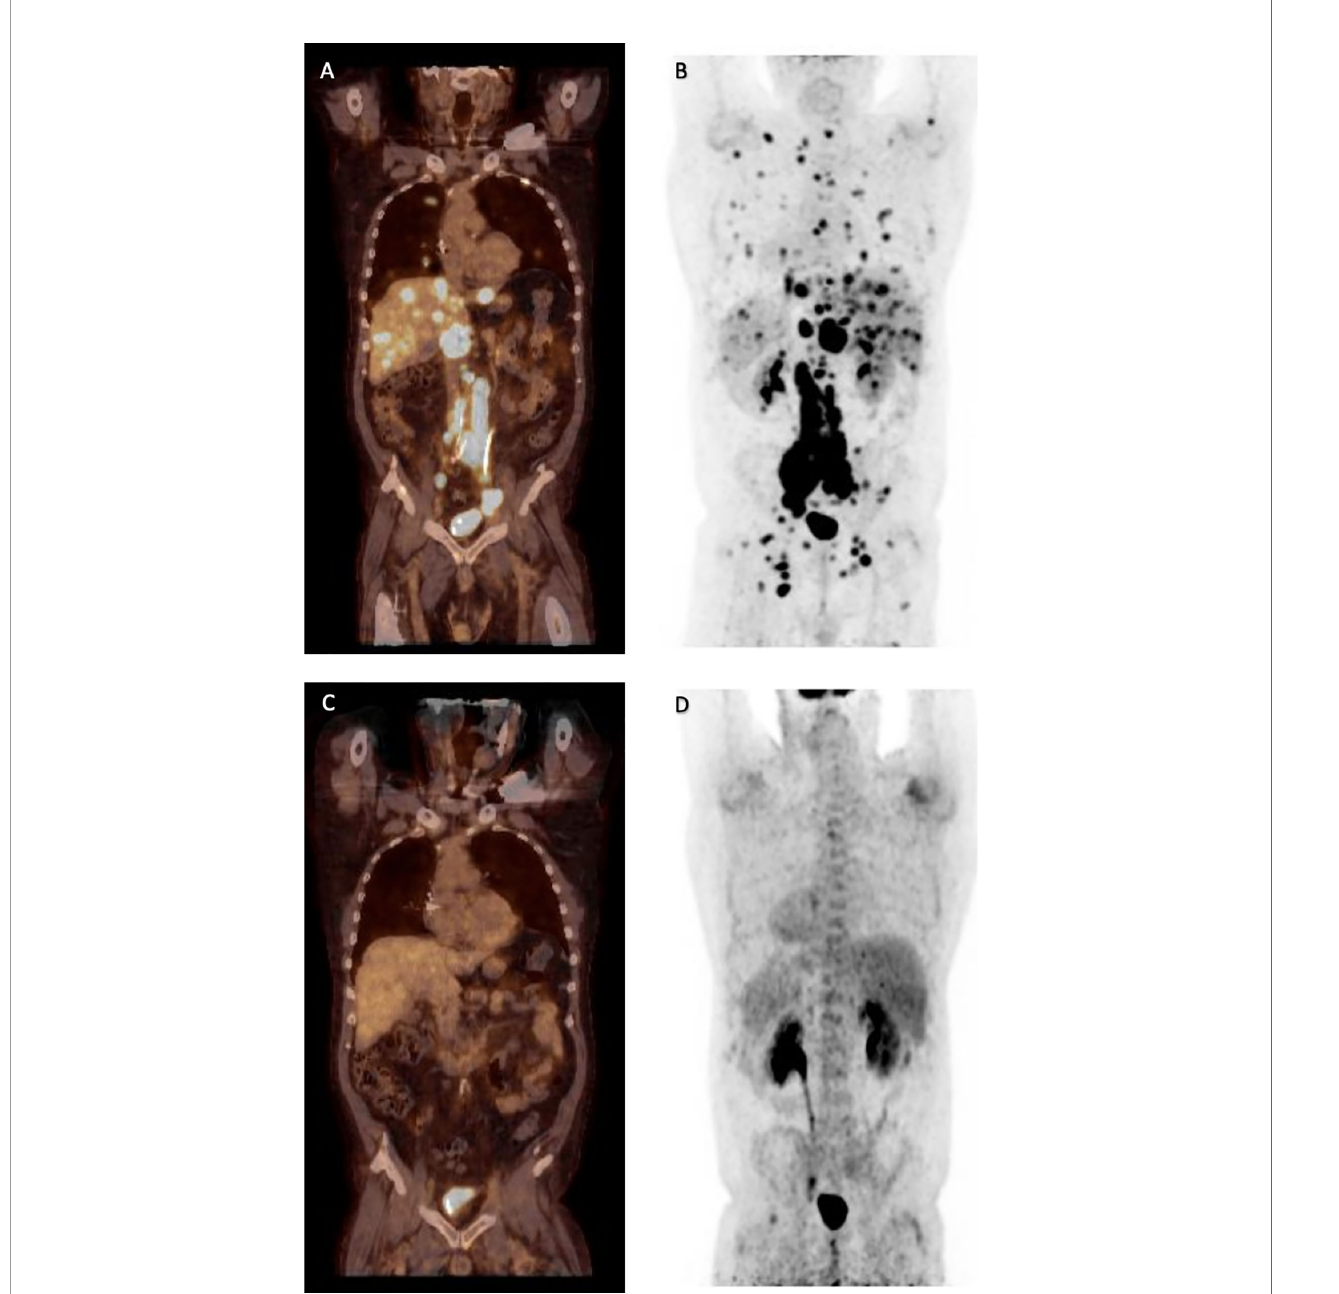
FIGURE 3 | Positron emission tomography with (A, C) and without computed tomography co-registration (B, D) in ventral (A, C) and dorsal view (B, D) . Disseminated manifestations of diffuse large B-cell lymphoma refractory to chemoimmuntherapiy prior to CAR-T cell therapy (A, B) and in remission three months after anti-CD19 CAR-T treatment with